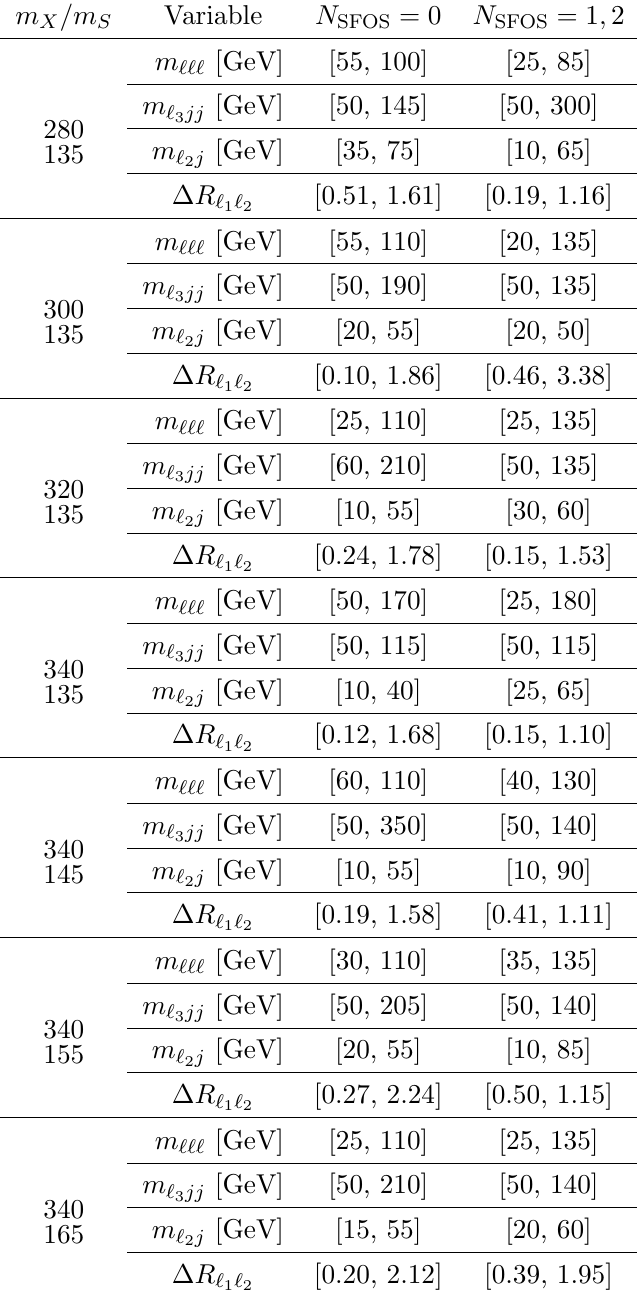
Table 9 . Optimised selection criteria for the X ! SS searches in the three lepton channel. The selection criteria are chosen to ensure constant signal selection e(cid:14)ciency between the N SFOS = 0 and N SFOS = 1 ; 2